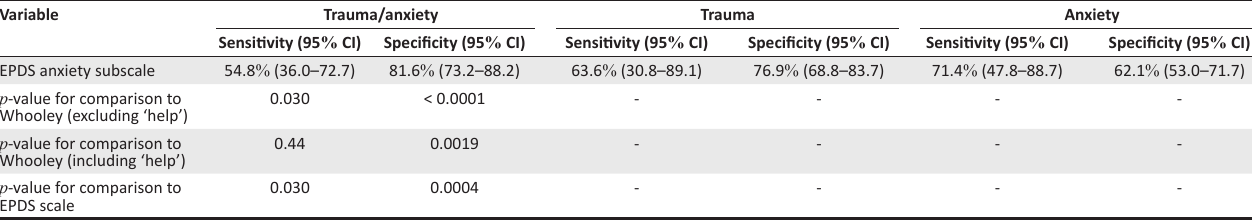
TABLE 3b: Comparison of screening tools, sensitivity and specificity, with confidence intervals.